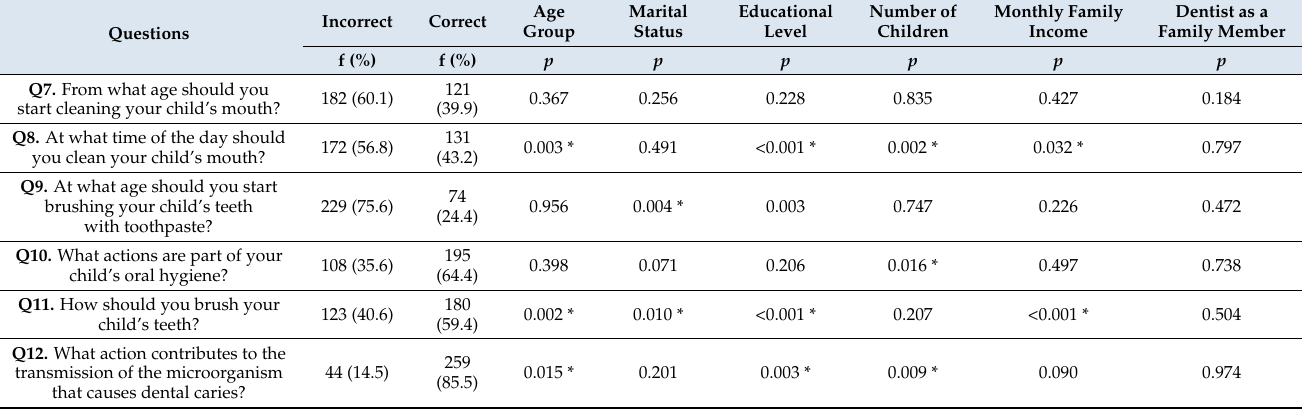
Table 3. Knowledge of early postpartum women about oral hygiene in infants aged 0 to 2 years old, associated with sociodemographic